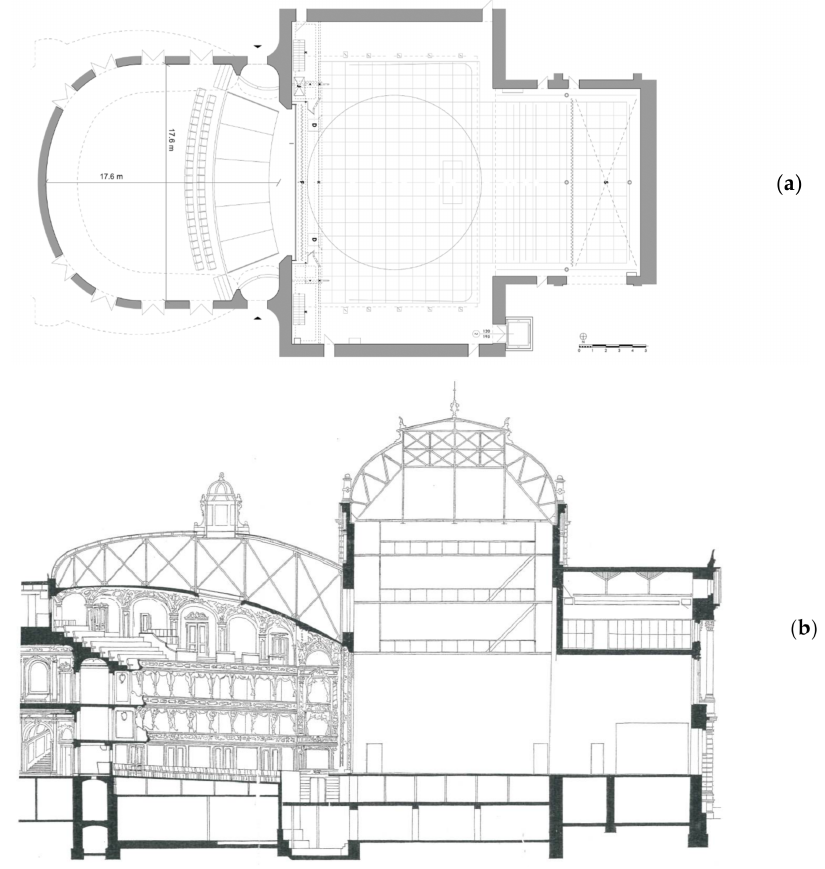
Figure 2. Internal organization of the National theater of Zagreb: plan layout of ground floor ( a ) and longitudinal section ( b